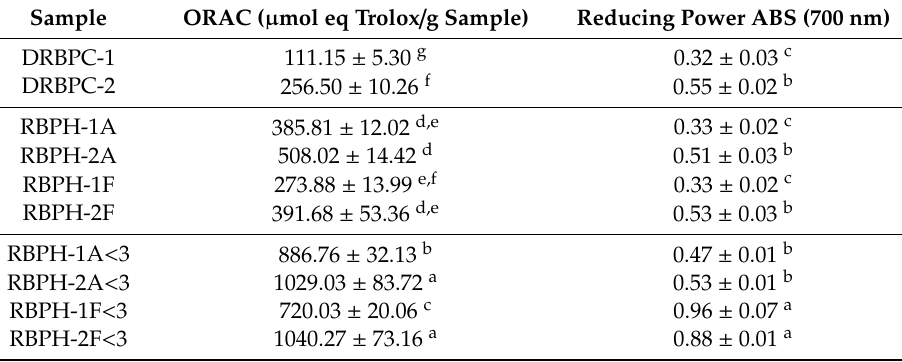
Table 1. ORAC (oxygen radical absorbance capacity) values and reducing power analysis of defatted rice bran protein concentrates (DRBPC-1 and DRBPC-2), protein hydrolysates with alcalase (RBPH-1A and RBPH-2A) and flavorzyme (RBPH-1F and RBPH-2F), and fractions with molecular mass smaller than 3 kDa (RBPH-1A < 3, RBPH-2A < 3, RBPH-1F < 3, and RBPH-2F < 3). Values given are the means ± standard deviation of three measurements. The same letters indicate no statistical di ff erences ( p > 0.05). Significance was estimated using one-way